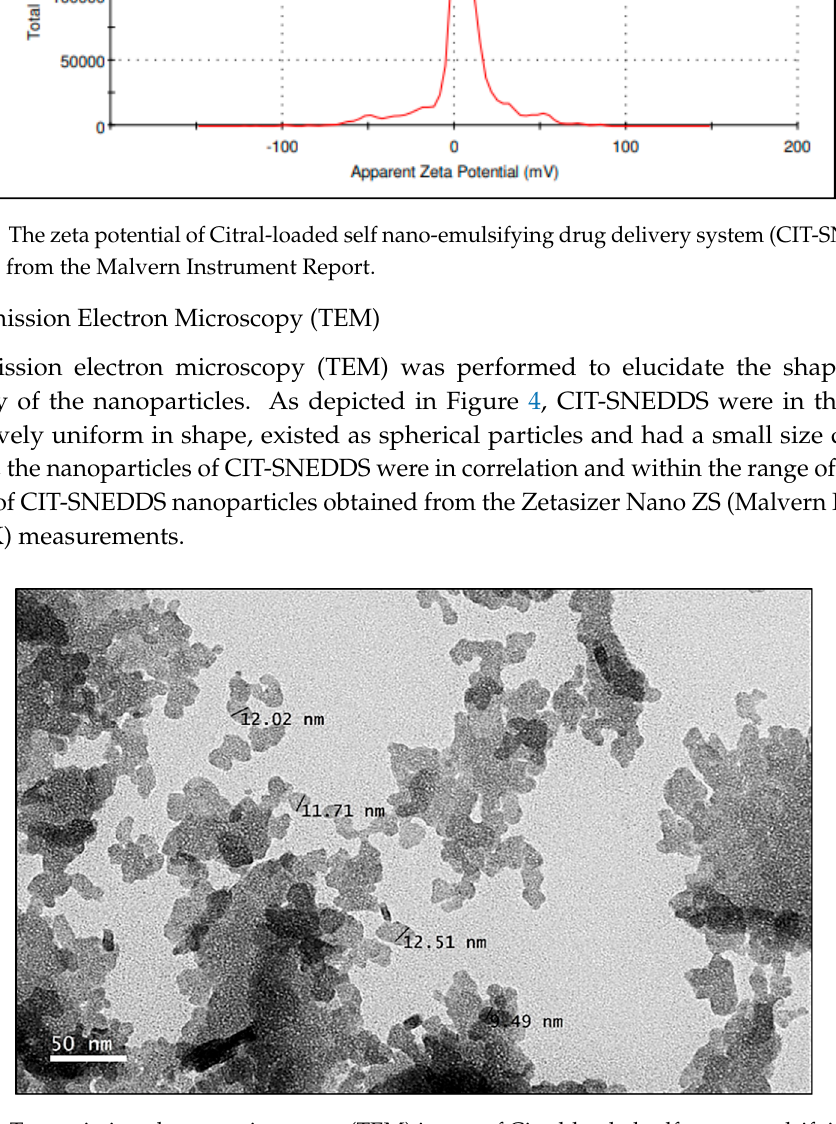
drug delivery system (CIT-SNEDDS) at 800,000 × magnification prepared by negative staining. delivery system (CIT-SNEDDS) at 800,000 × magnification prepared by negative